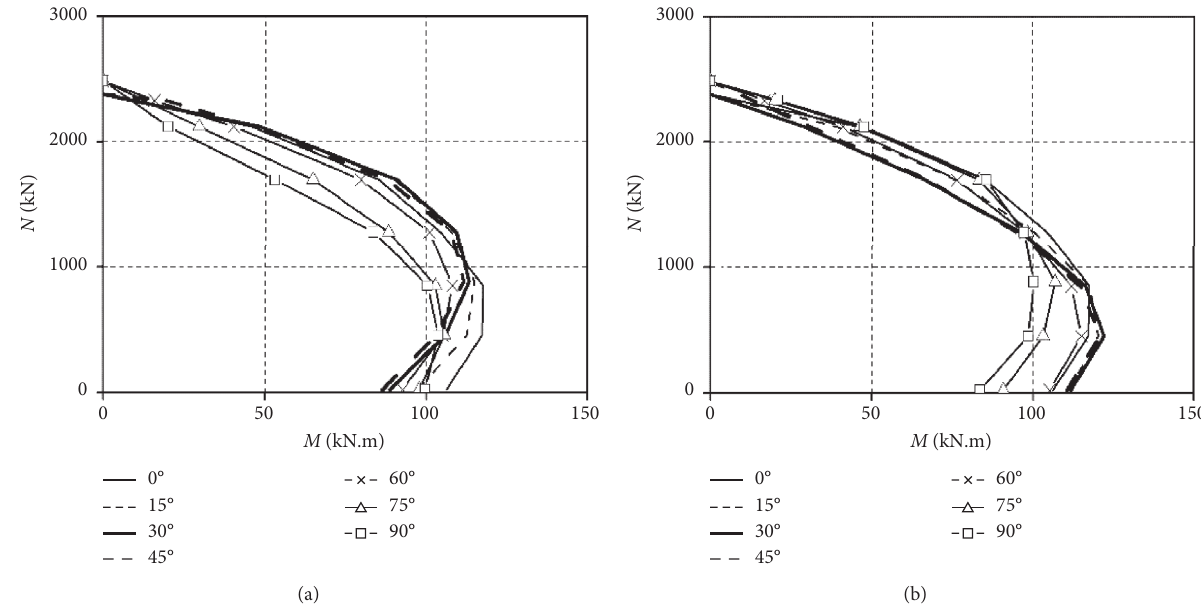
Figure 17: Influence of loading angle θ on the component resistance correlation curves. (a) Positive angle loading. (b) Negative angle loading.